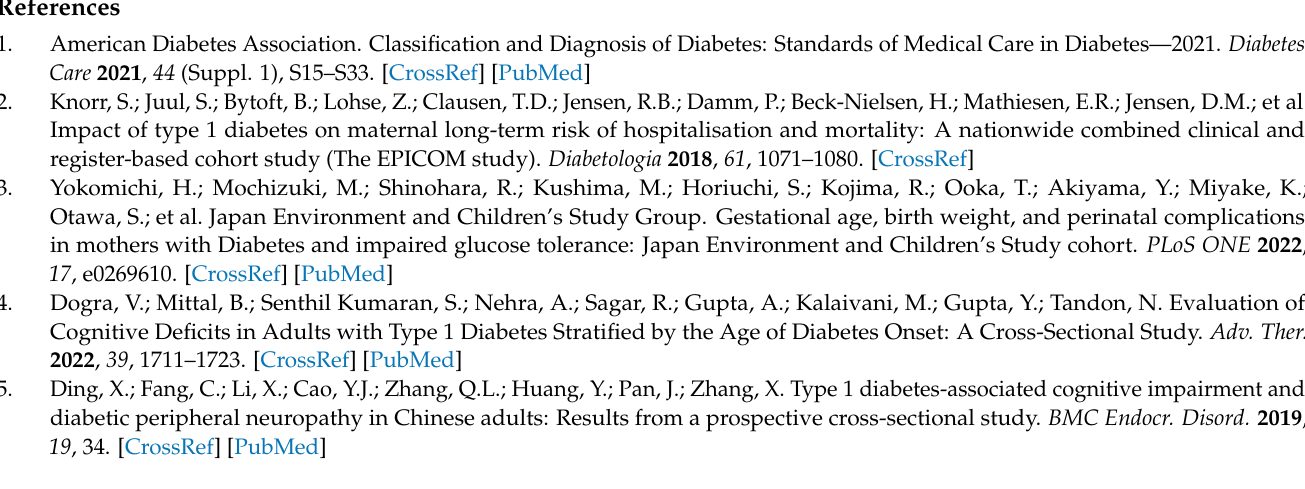
Table S1: Characteristics of studies used in the